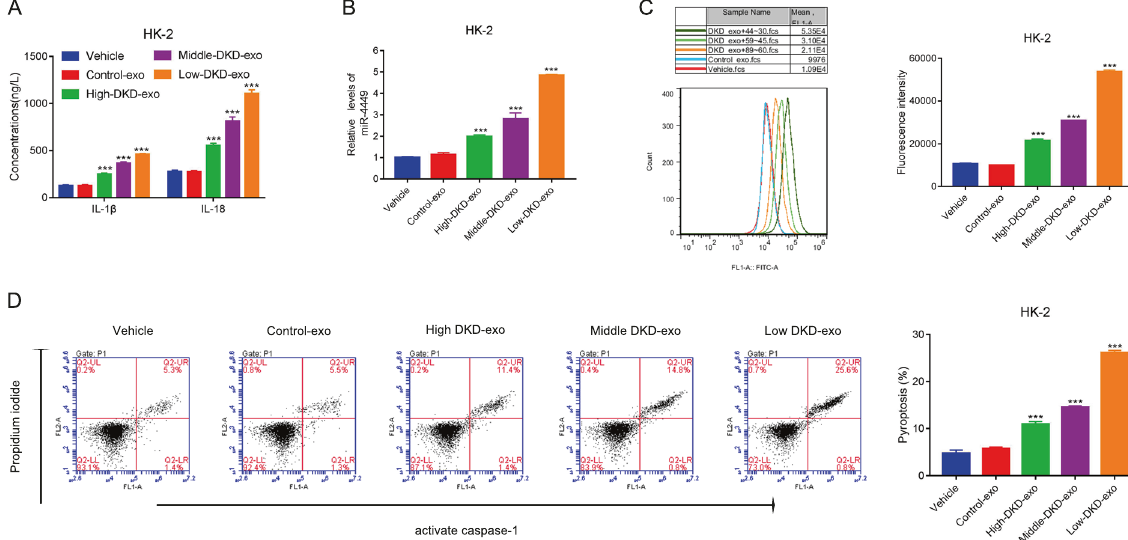
Fig. 3 DKD exosomes promote ROS accumulation and pyroptosis in kidney cells. HK-2 cells were treated with exosomes isolated from patients with DKD with different degrees of disease progression and controls. A The secretions of IL-1 β and IL-18 were measured using ELISA. B The relative level of miR-4449 was measured with RT-PCR. C The reactive oxygen species (ROS) level was measured using a DCFDA assay kit. D Pyroptosis was measured through quanti fi cation of cells with active caspase-1. *** P < 0.001 vs. control-exo.